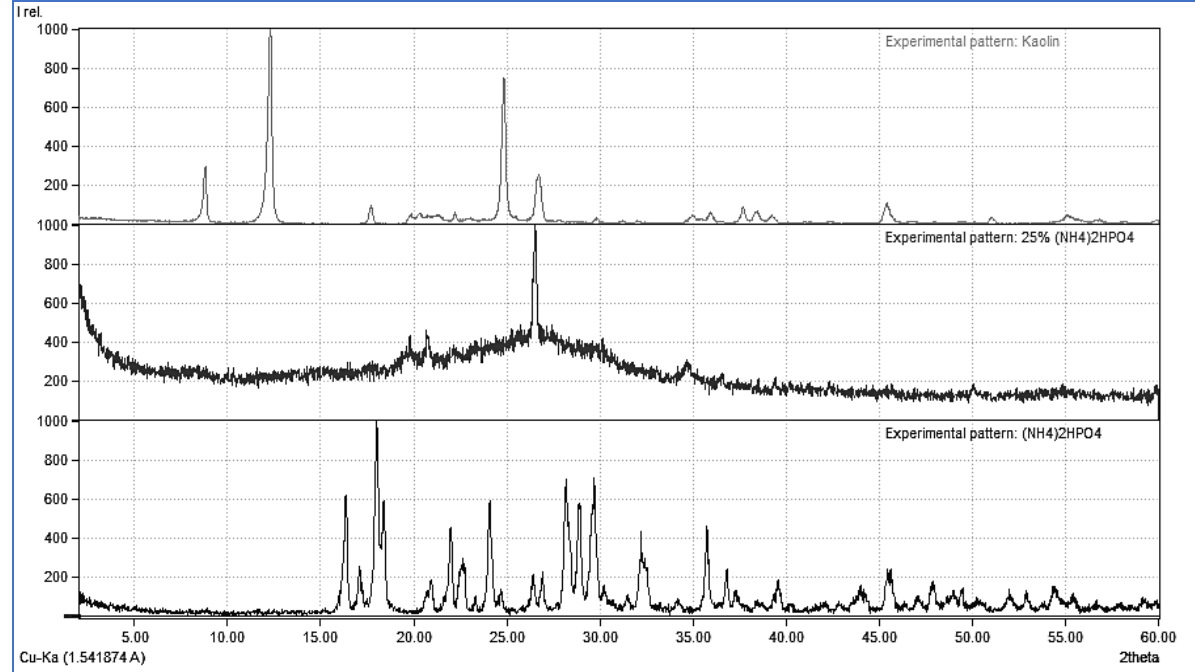
Figure 1: XRD patterns of kaolin–(NH4)2HPO4 sample system milled at speed 600 rpm for 120 min [13] Figure 1. XRD patterns of kaolin–(NH 4 ) 2 HPO 4 sample system milled at speed 600 rpm for 120 min.